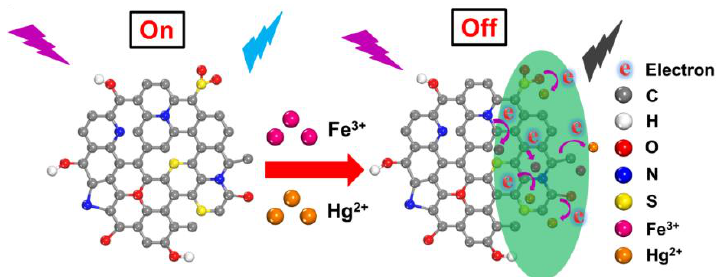
Figure 3. Schematic diagram of N, S-GQDs as a fluorescence probe for the detection of Fe 3+ or Hg 2+ ions .